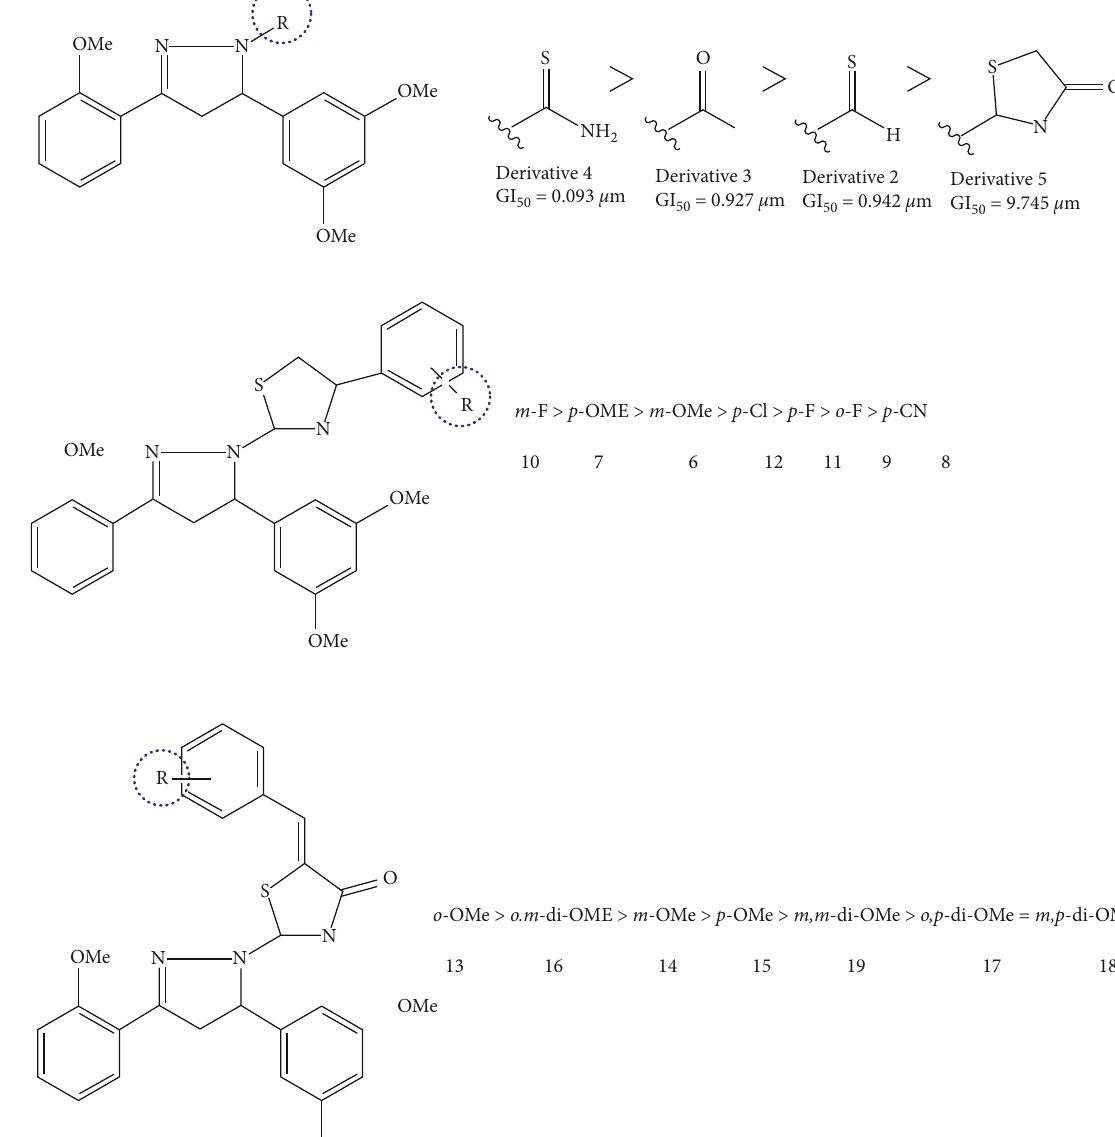
50 structure-activity relationships